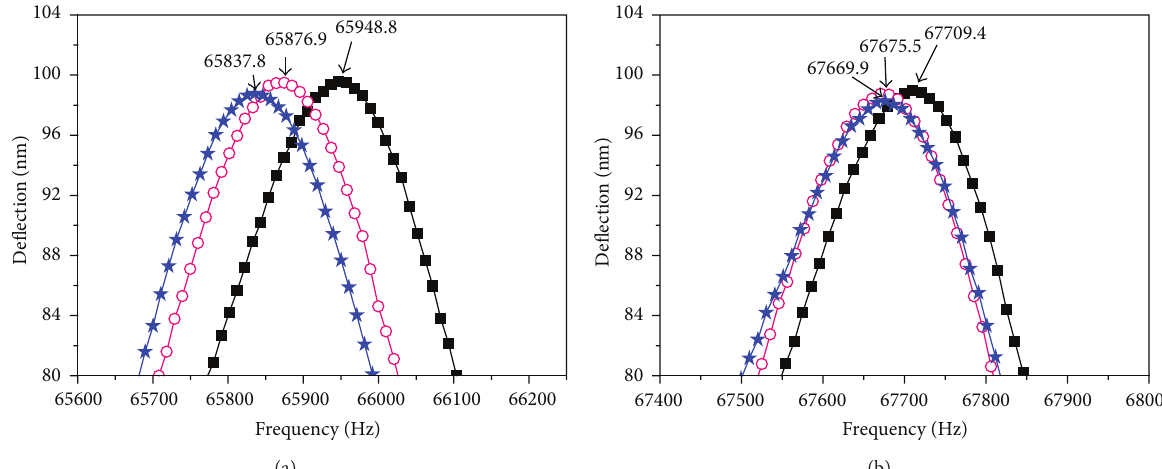
Figure 2: Cantilever frequency shifts at each step in the cantilever modification process for (a) glucose and (b) galactose. The symbols ( ◼ , I , and 󳀅 ) represent APS, APS/Con A, and APS/Con A/glucose or galactose, respectively.